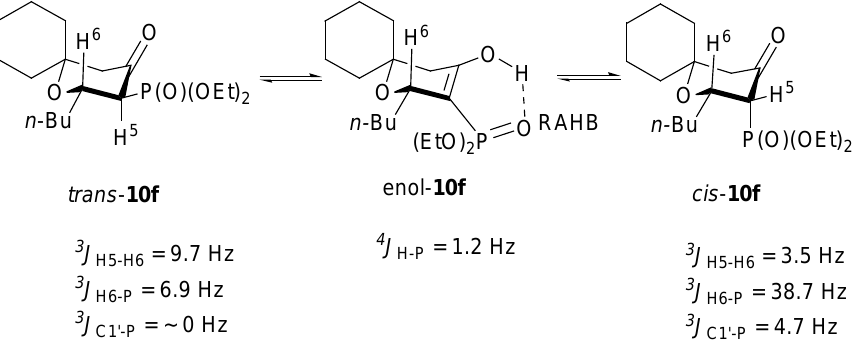
Figure 2. Preferred conformations of trans-, cis- and enol- 10f and characteristic coupling constants.